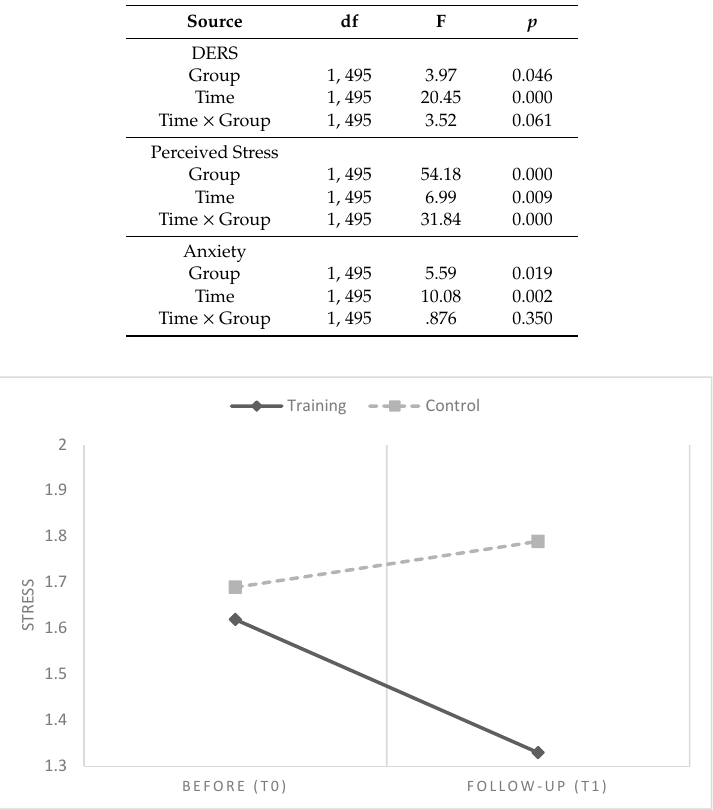
Table 4. ANOVA 2 (Time) × 2 (Group) results.